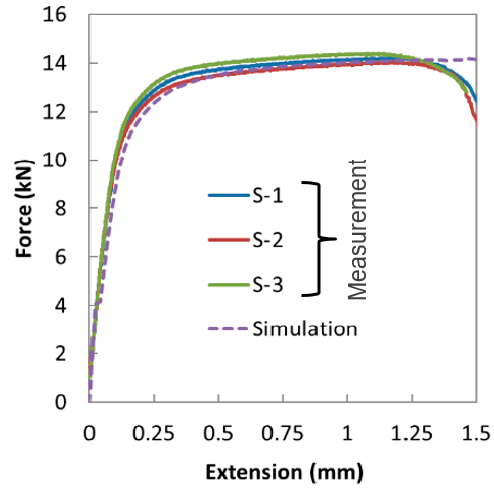
Figure 19. Comparison of forces for shear test.